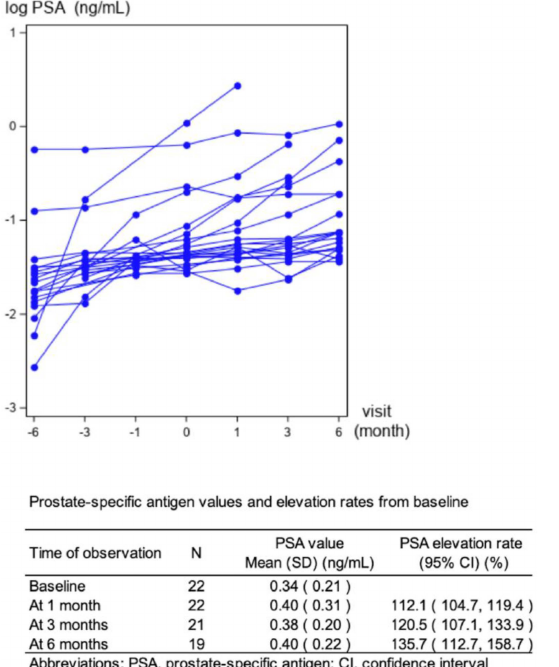
Figure 1. Prostate-specific antigen levels before and after administration of Brazilian green propolis.